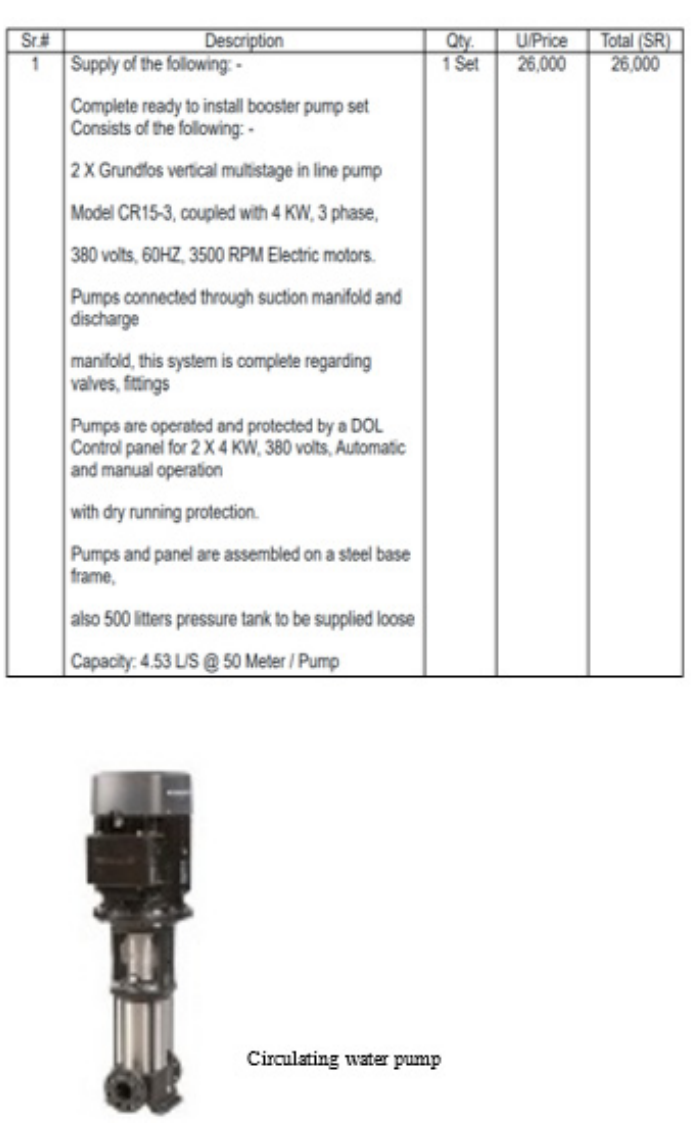
Figure A3. Water pumps specifications, figure, and price.